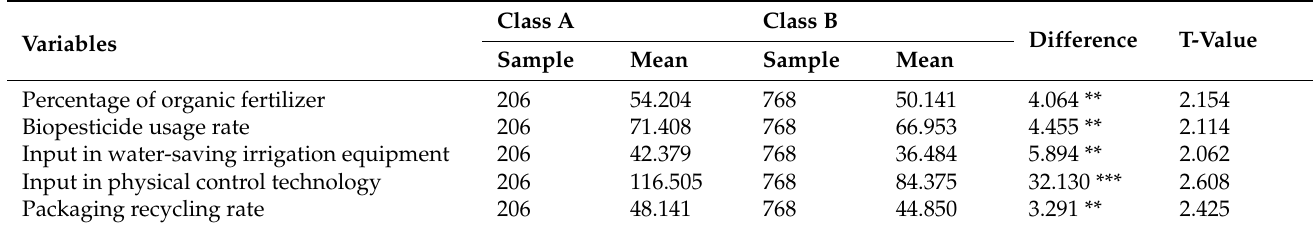
Table 3. Comparison of the main indicators of green production transition of potential